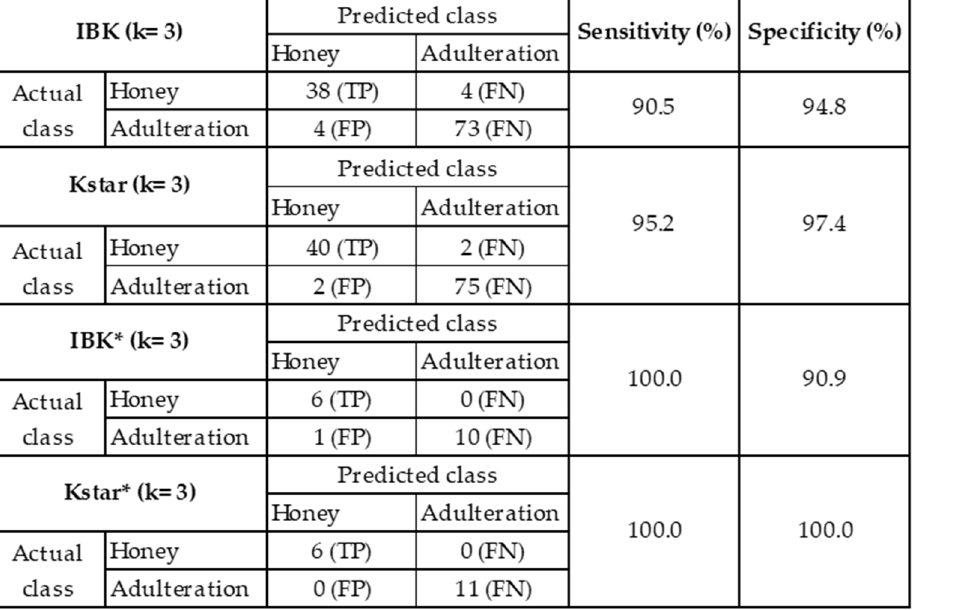
Figure 5. Confusion matrices, sensitivity, and specificity of classifiers IBK (k = 3), Kstar (k = 3), IBK* (k = 3), and Kstar* (k =